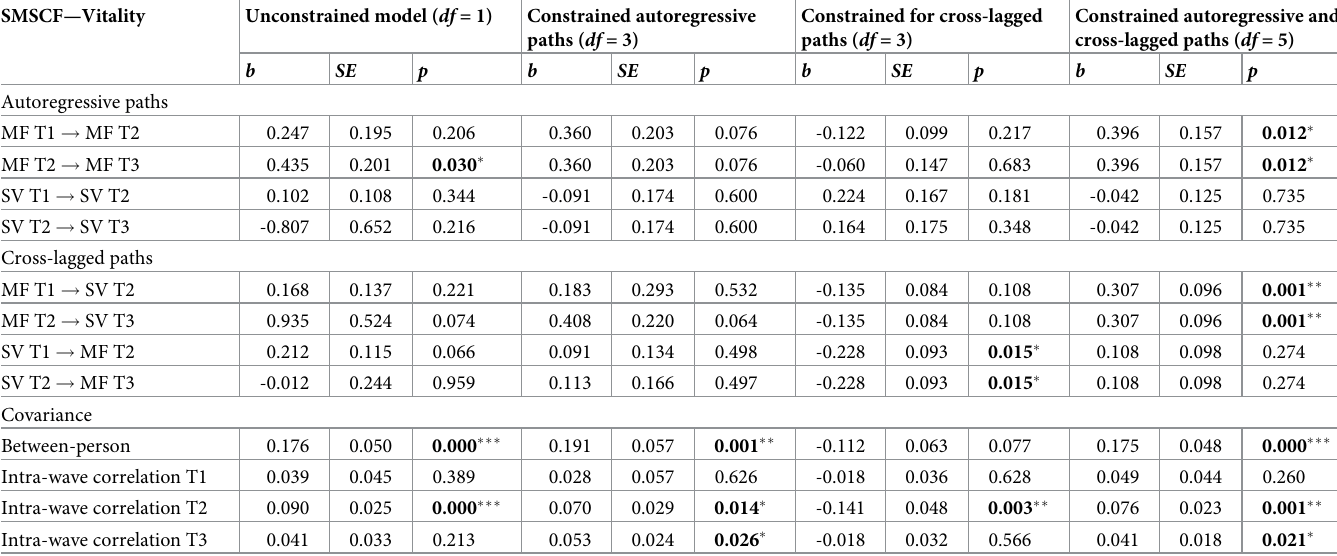
Table 10. Reciprocal relationships between mindfulness and subjective vitality. SMSCF—Vitality Unconstrained model ( df = 1)